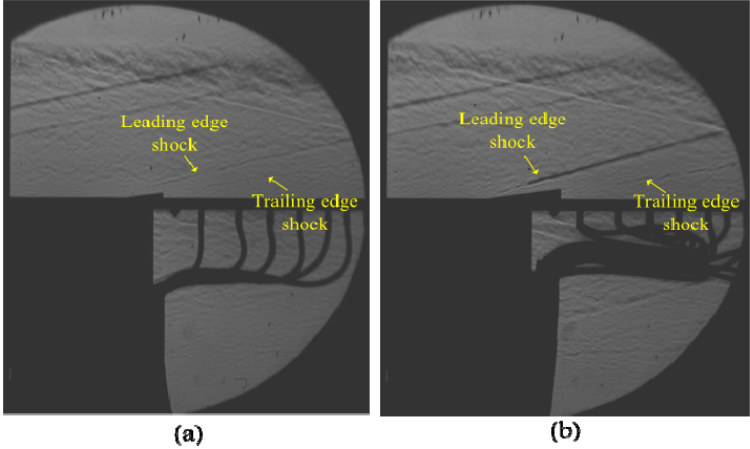
Figure 8. Comparison of schlieren images of MR40 ( a ) and MR80 ( b